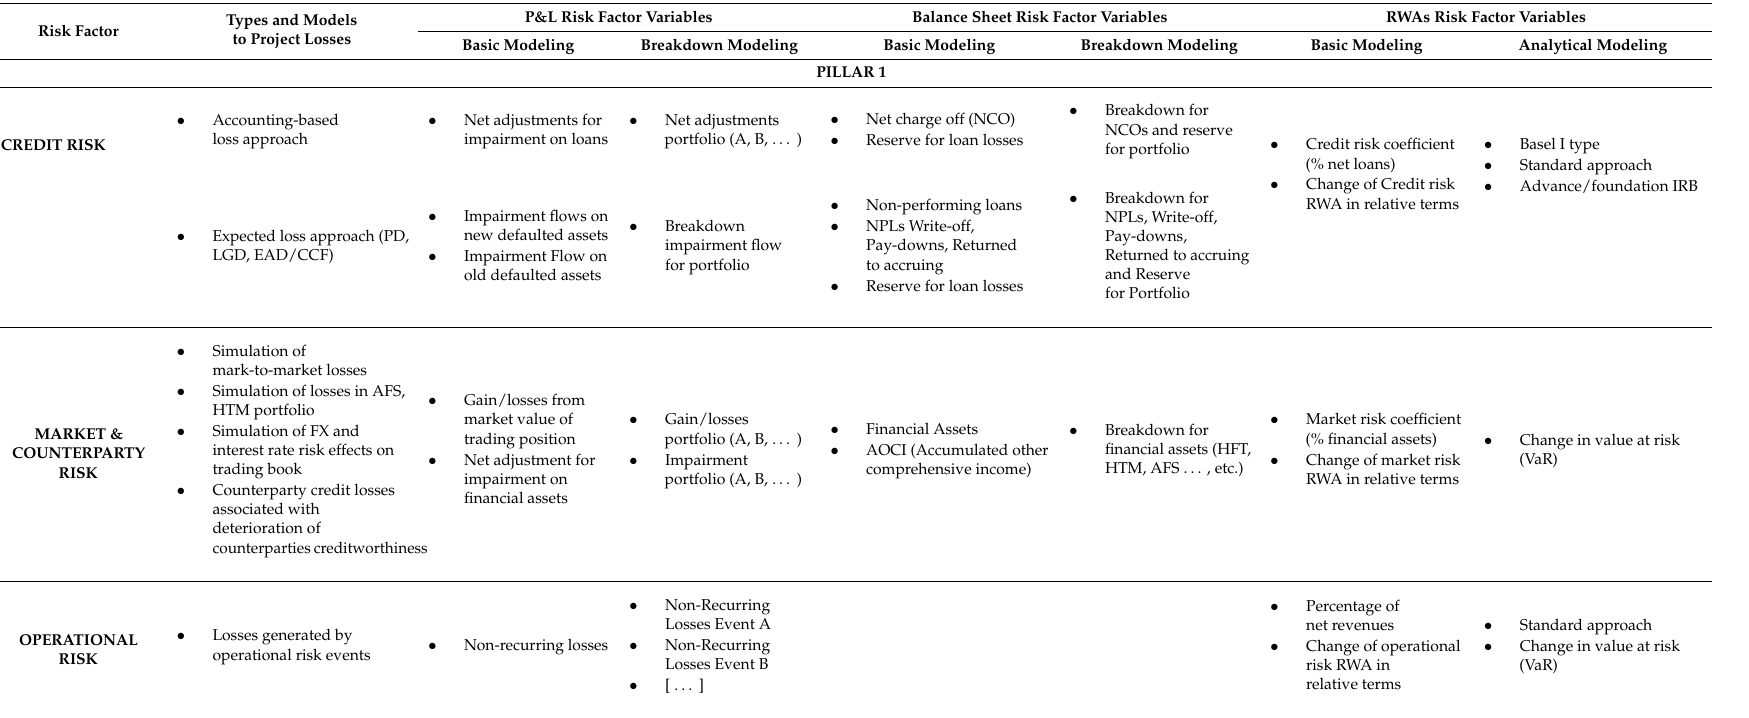
Table 1. Stress test framework: risk factor